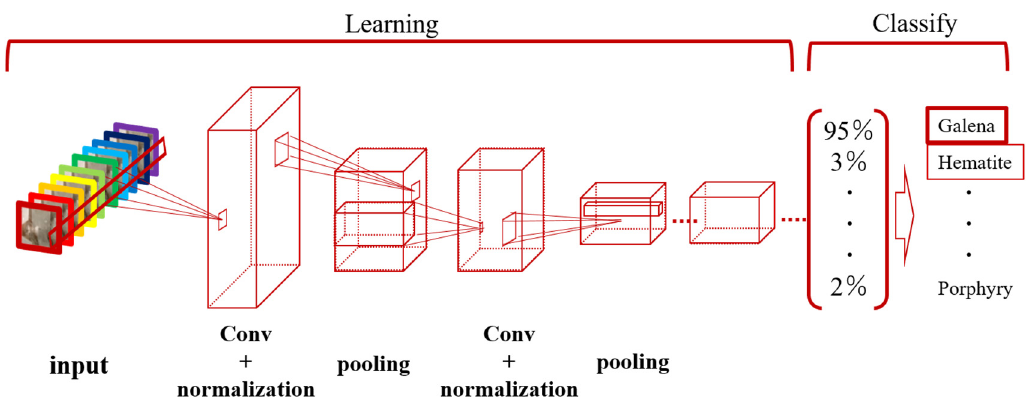
Figure 3. Structure of the CNN for hyperspectral data.